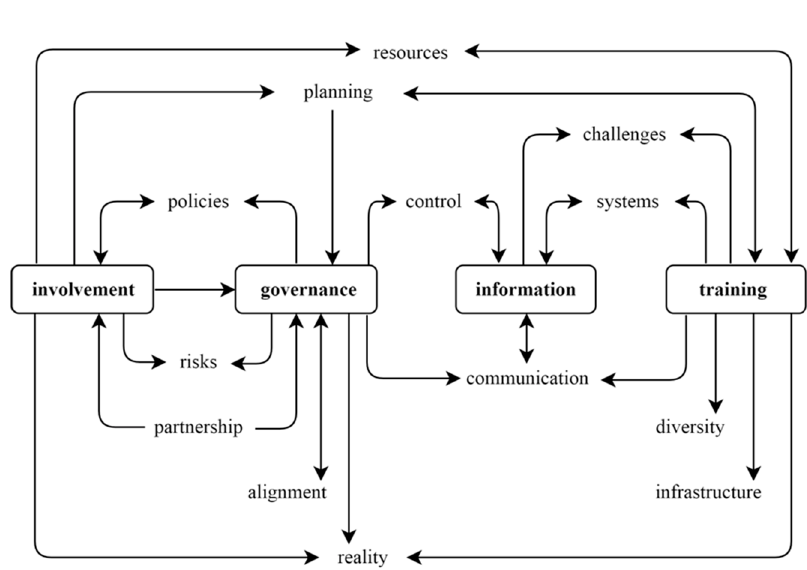
Figure 8. Base Scenario to Construct the Macro Action Plan.